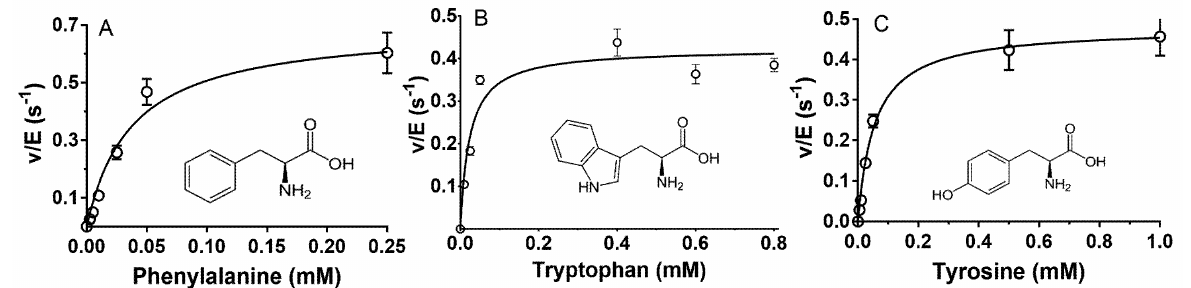
Figure 4. Steady-state kinetic analysis of the reactions of aromatic amino acid substrates with P. luteoviolacea CPMOR-1 LAAO. The analysis of the data is shown for ( A ) Phenylalanine, ( B ) Trypto- phan and ( C ) Tyrosine. The lines are the fits of the data to Equation (1). Data points are the average of three replicates. The structures of each amino acid are shown with each plot.